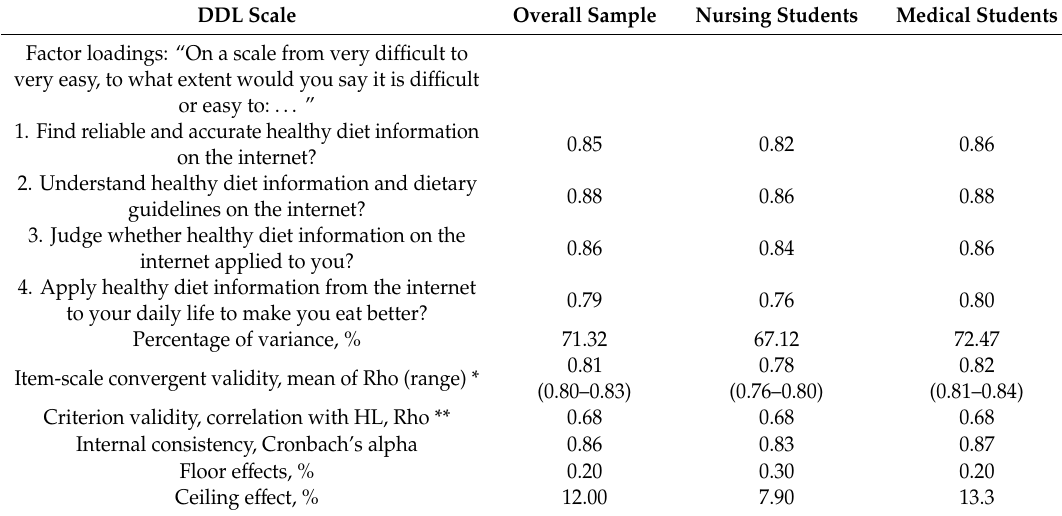
Table 3. Construct, convergent, criterion validity, internal consistency, floor, and ceiling e ff ects of digital healthy diet literacy scale ( N = 7616). DDL Scale Overall Sample Nursing Students Medical